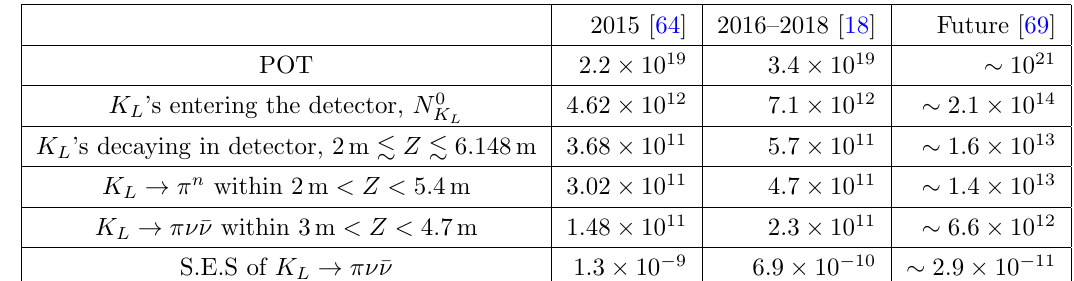
Table 1 . Summary of expected number of Kaons in di(cid:11)erent regions of the experiment. The number of protons on target (POT), the number of Kaons entering the detector, N 0 event-sensitivity (S.E.S) are given in the literatures, while number of Kaons decaying in the various regions is calculated with the measured K L momentum distribution. The S.E.S. does not scale